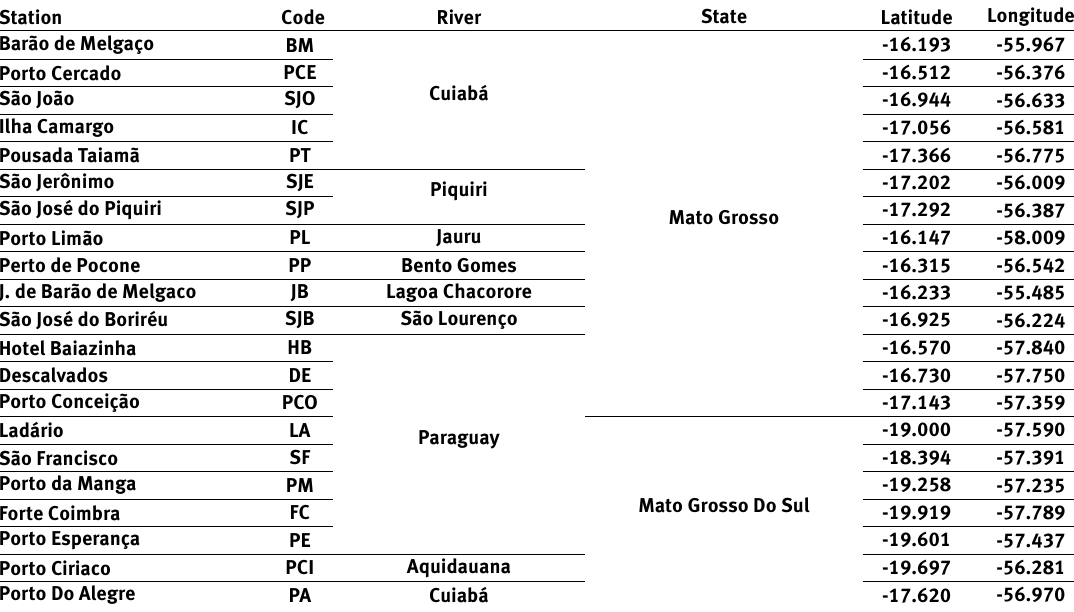
Table 1. Name of Station, Code, River and State, for the ANA stations in the Pantanal.